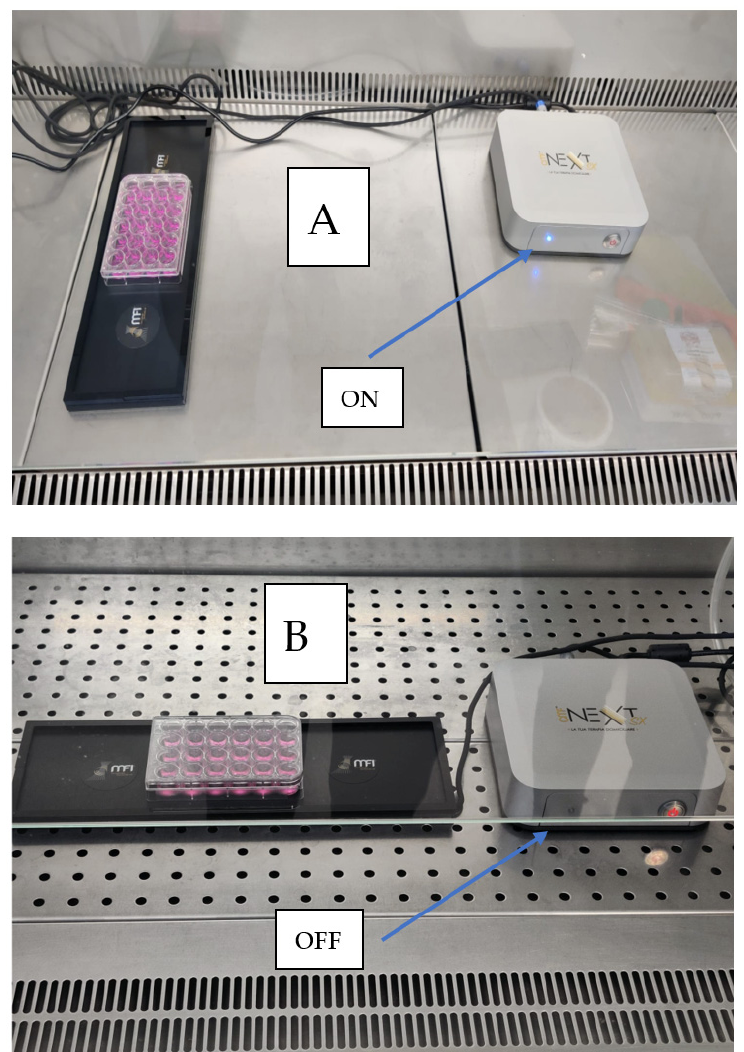
Figure 7. The treatment of the cell cultures. In detail, the cells cultured in 24-well plates were posi- tioned corresponding to the experimental set-up, then exposed to the stimulation at room tempera- ture ( A ) under biological flow. The control cultures were positioned onto the device in the same manner as the exposed cultures but without receiving stimulation ( B